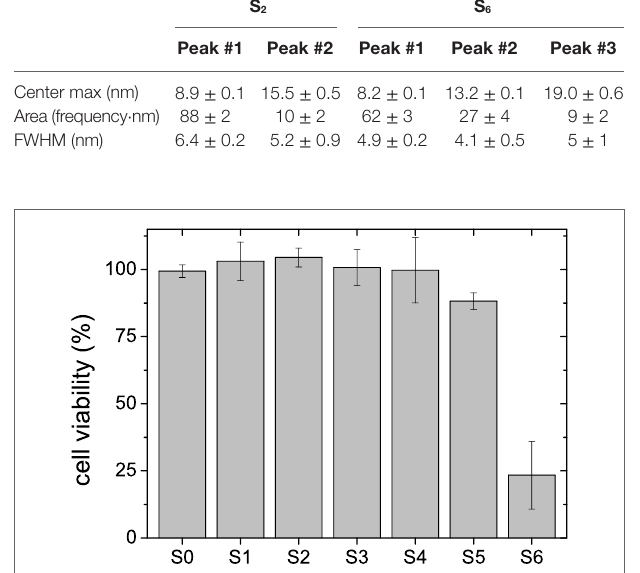
FigUre 3 | Measured cell viability (%) obtained from vascular smooth muscle cells using the colorimetric MTT (3-(4,5-dimethylthiazol-2-yl)- 2,5-diphenyltetrazolium bromide) assay when exposed to different amounts M-sre samples (from s 0 to s 6 ) . Results are expressed as the